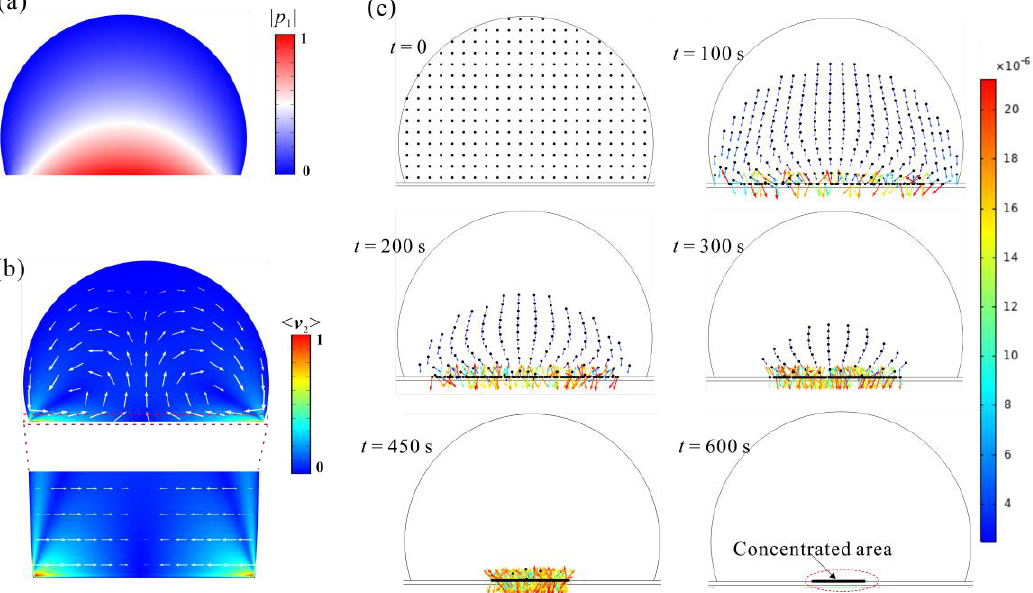
Figure 3. ( a ) The normalized acoustic pressure distribution. ( b )The normalized acoustic streaming, the arrows in the primary and enlarged area are < v 2 > and < v 2x >. ( c ) The time-series distribution of 10 µ m particles upon d m = 10 nm. The arrow represents the velocity direction, and the color Table 1. Strengths and limitations of current commercially available ROS detection tools for male represents the magnitude of velocity, infertility.